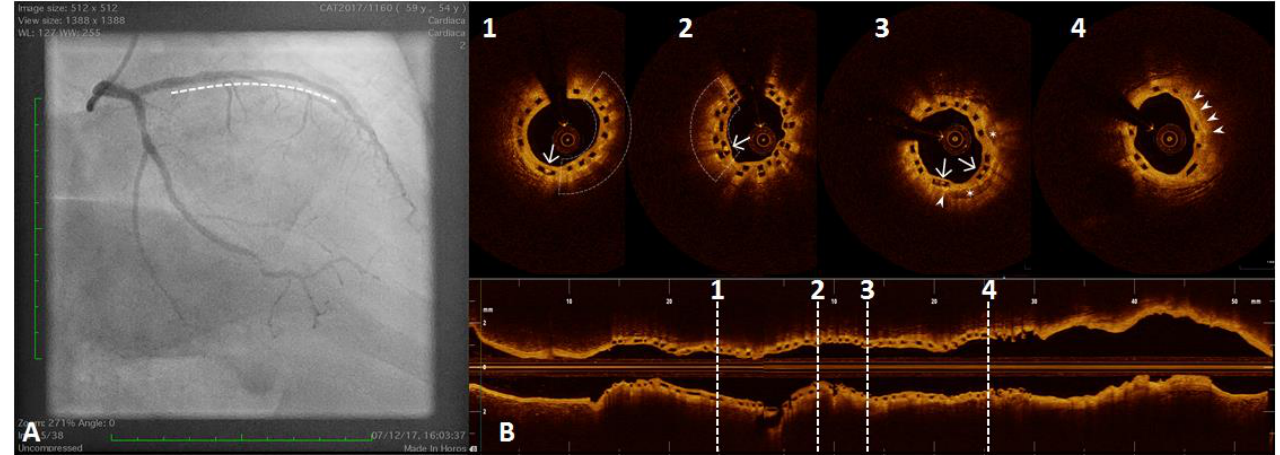
Figure 6. A 54 year old woman after a scheduled angiogram and OCT pull-back 3 years after an acute coronary syndrome. During index procedure 2 bioresorbable vascular scaffolds (BVS) were implanted. Coronary angiography showed satisfactory angiographical result (panel ( A ), white line). OCT pull-back confirmed a complete struts coverage and an acceptable lumen area (panel ( B )), even at the overlapping site (2). Black boxes are typical OCT images of BVS (1,2,3 and 4). Some black box inclusions are detected (1,2 and 3 – white arrows) representing scaffold reabsorption processes. Some areas immediately below the boxes showed bright spots indicating inflammation with macrophages activation (1 and 2 - underlined area). These bright spots (3 and 4, white triangle) have been detected closely to calcium arch (3, stars) and in a fibro-lipidic plaque (4).